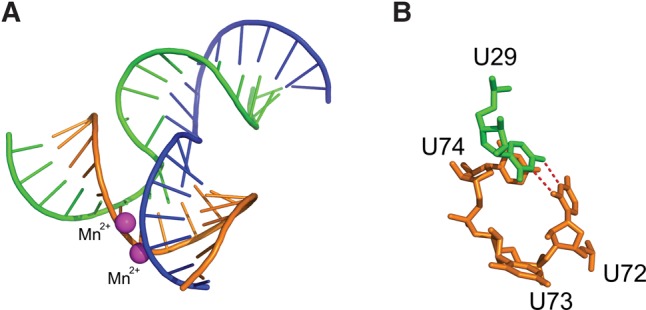
phi29 pRNA 3WJ structure (Zhang et al. 2013). (A) 3WJa is in green, 3WJb is in orange, and 3WJc is in blue. Bound divalent metal ions (Mn2+) are in magenta. (B) Bulge residues at the 3WJ (i.e., U29/U72–73–74) are shown as sticks. A cis base pair forms between the Watson–Crick edges (Leontis et al. 2002) of U29 and U72. U29 and U74 form a base stack.